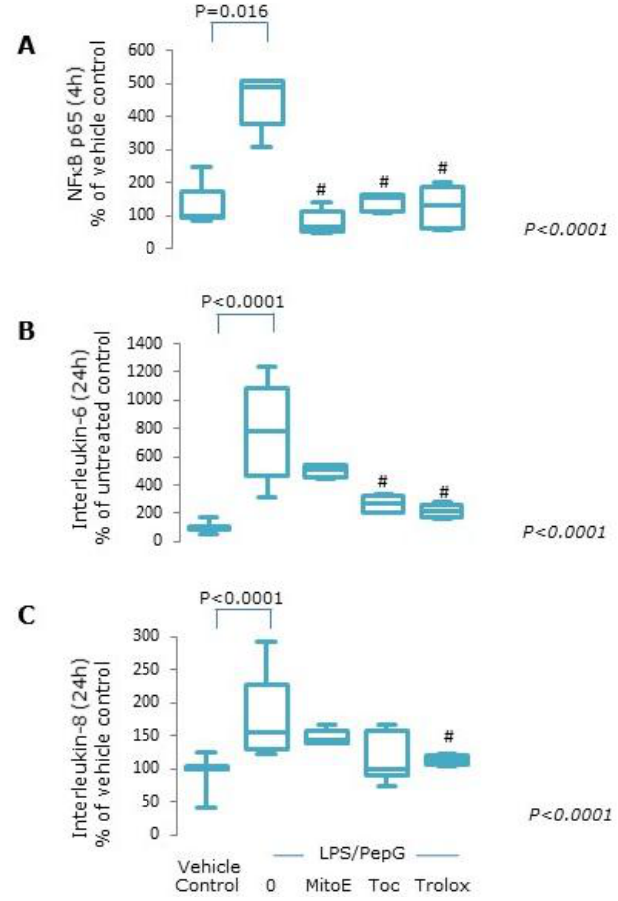
Figure 4. NFκB activation and cytokine expression. Endothelial cells treated with vehicle control, lipopolysaccharide plus peptidoglycan (LPS/PepG) alone, or LPS/PepG plus 5 μM MitoVitE (MitoE), tocopherol (Toc) or Trolox for 4 or 24 h. ( A ) Nuclear NFĸB p65, ( B ) interleukin-6 (IL-6) and ( C ) interleukin-8. Box and whisker plots show median, interquartile and full range ( n = 6). p value in italics refers to Kruskal–Wallis across LPS/PepG treated groups, # = significantly lower than LPS/PepG alone ( p < 0.05).